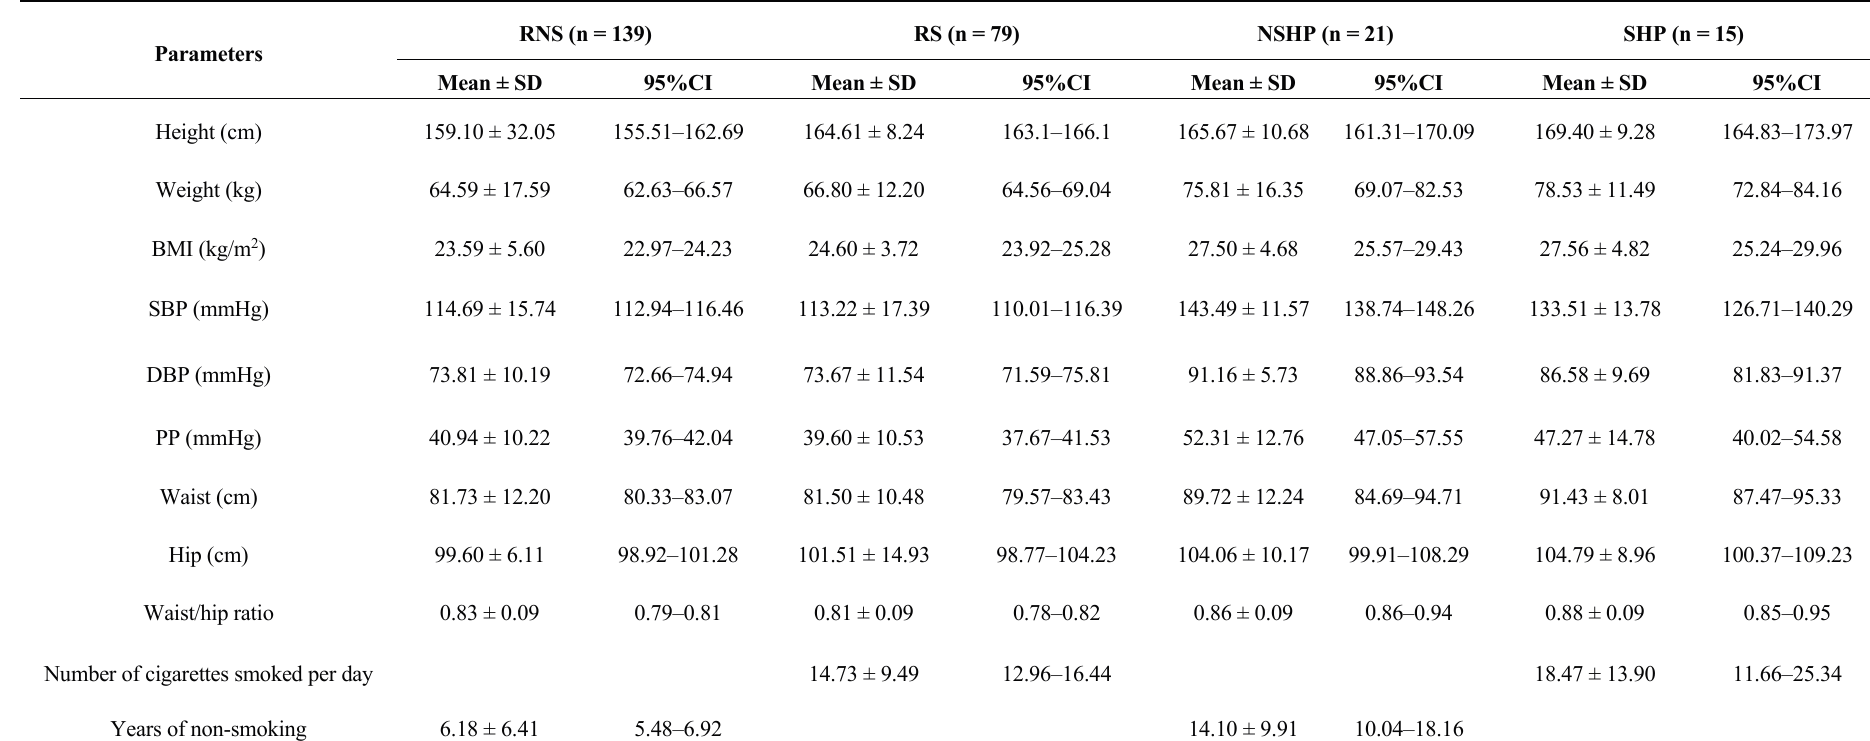
Table 1. Characteristics of hypertensive and non-hypertensive